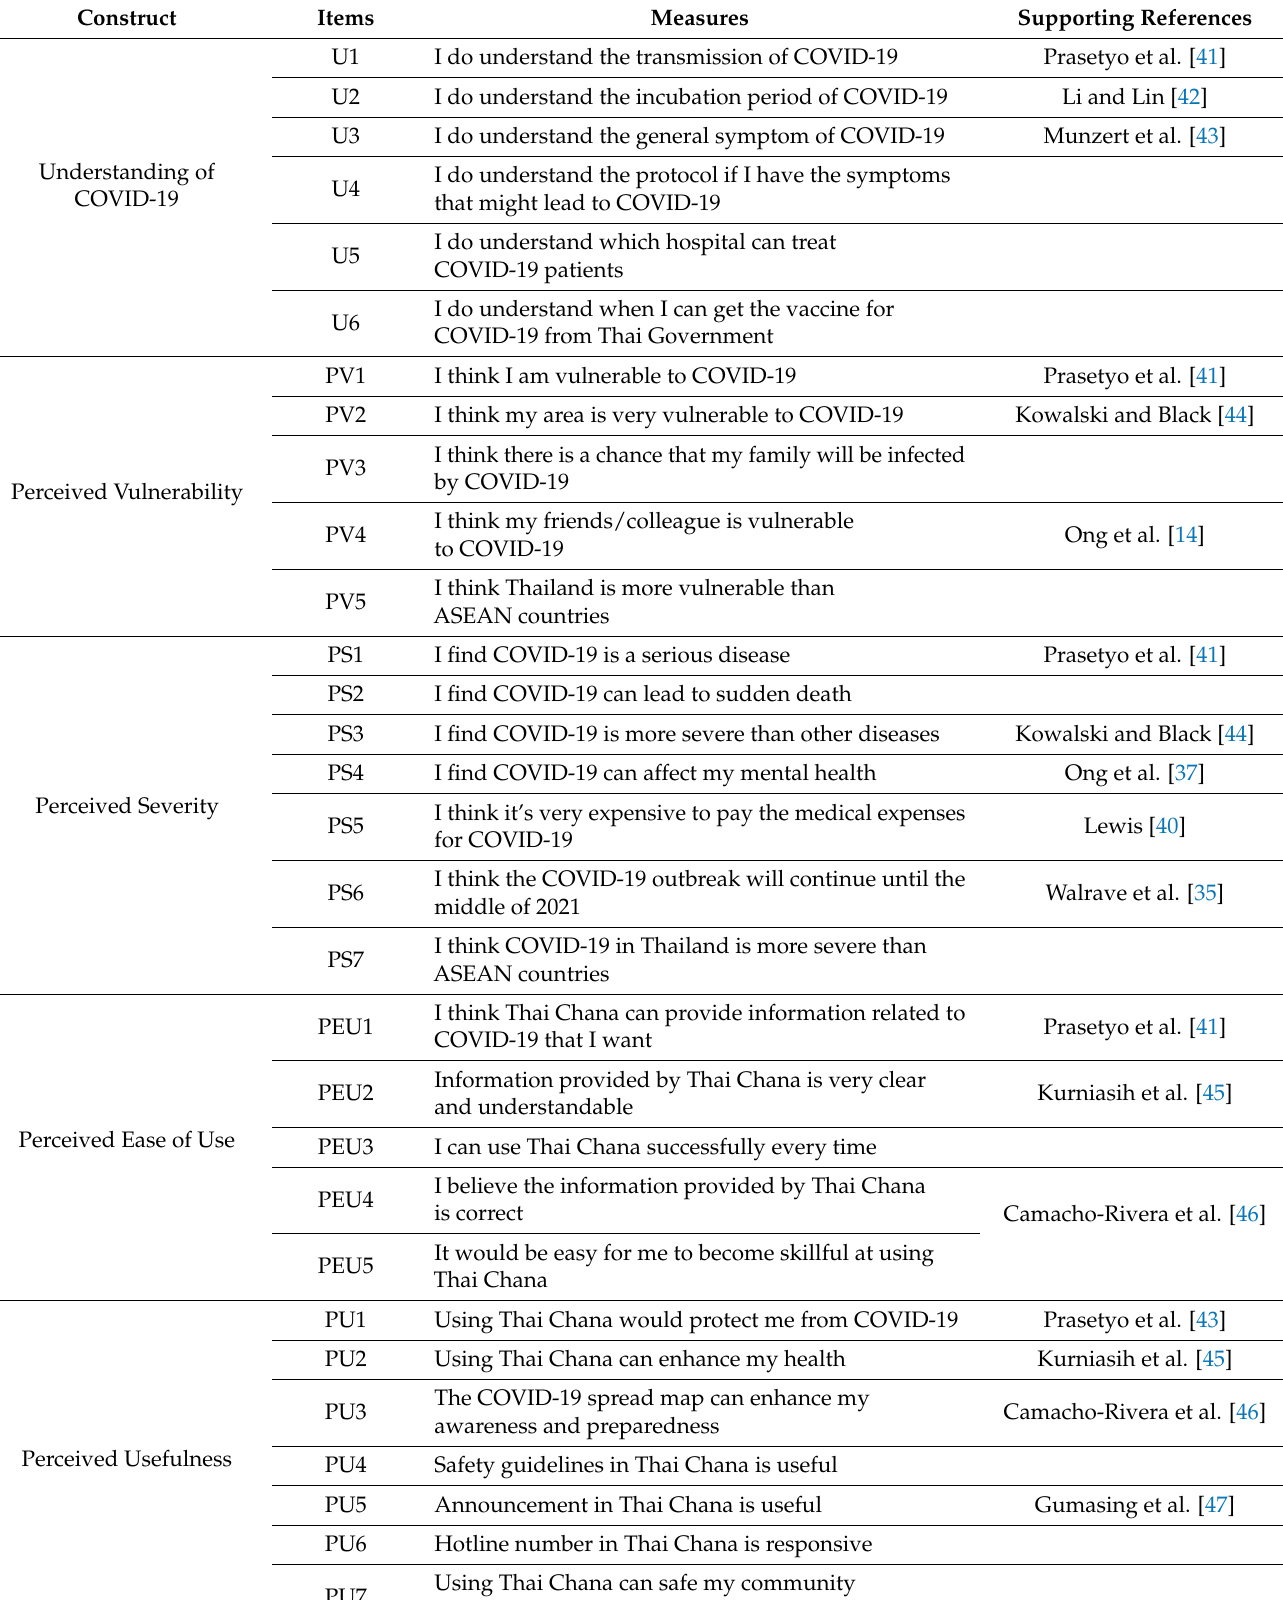
Table 1. Construct and measurement